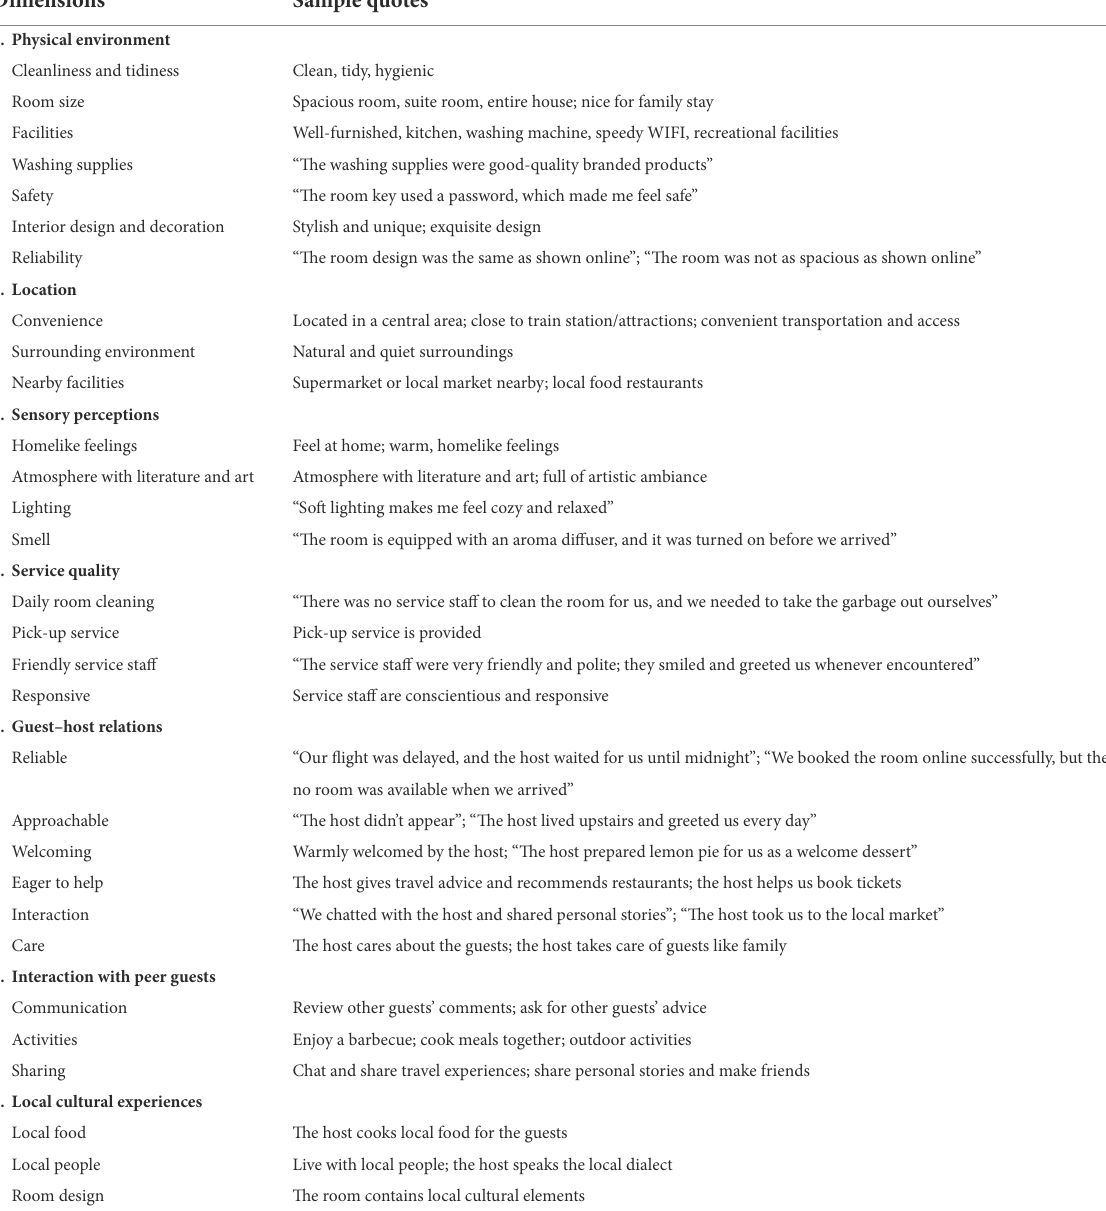
TABLE 1 Interview results of customers’ experiences with P2P accommodations–dimensions and items ( N =